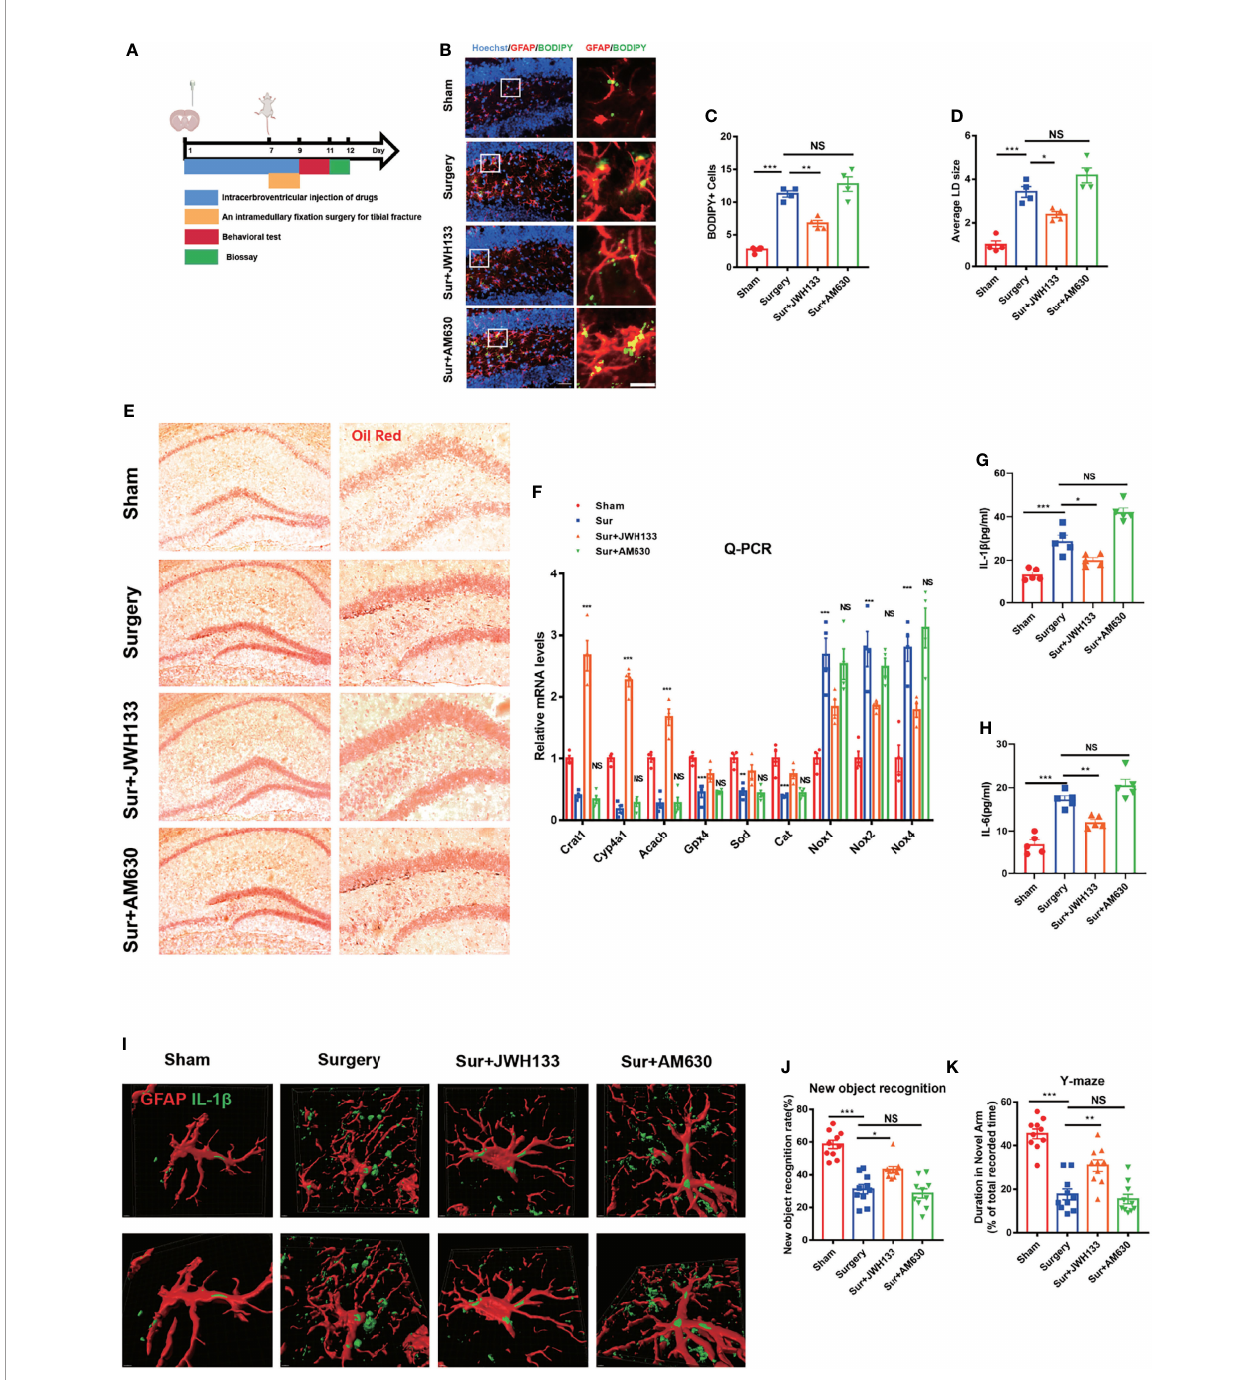
FIGURE 1 | (A) Experimental protocol and timeline. Administration of JWH133 or AM630 via the lateral ventricle of the mice by using a stainless steel tube 7 d before surgery; behavioral and biological testing 2 d after surgery. (B) Immuno fl uorescence staining of GFAP and BODIPY staining in the hippocampal DG brain region. Statistical data on BODIPY+ cells, with the average LD size (C, D) (means±SEM, n=4, scale bars=40 and 3 m m). (E) Oil Red O LD staining in the hippocampus (n=4, scale bars=200 and 100 m m). (F) RT-qPCR results for the relative mRNA expression levels of Crat, Cyp4a12a, Acacb, Gpx4, Sod, Cat, and Nox1,2,4 in the hippocampus (means±SEM, n=4). (G, H) ELISA of IL-1 b and IL-6 serum levels (n=5). (I) Co-labeling of GFAP and IL-1 b in the hippocampus, as detected by immuno fl uorescence assay. Analysis of the fl uorescence signal by using Imaris 9.0 to generate a 3D model (scale bars=2 m m). (J, K) New object recognition and Y-maze testing of mice in each group (means±SEM, n =10). NS means not signi fi cant, * P < 0.05, ** P < 0.01, *** P < 0.001 compared with the corresponding group, as determined by